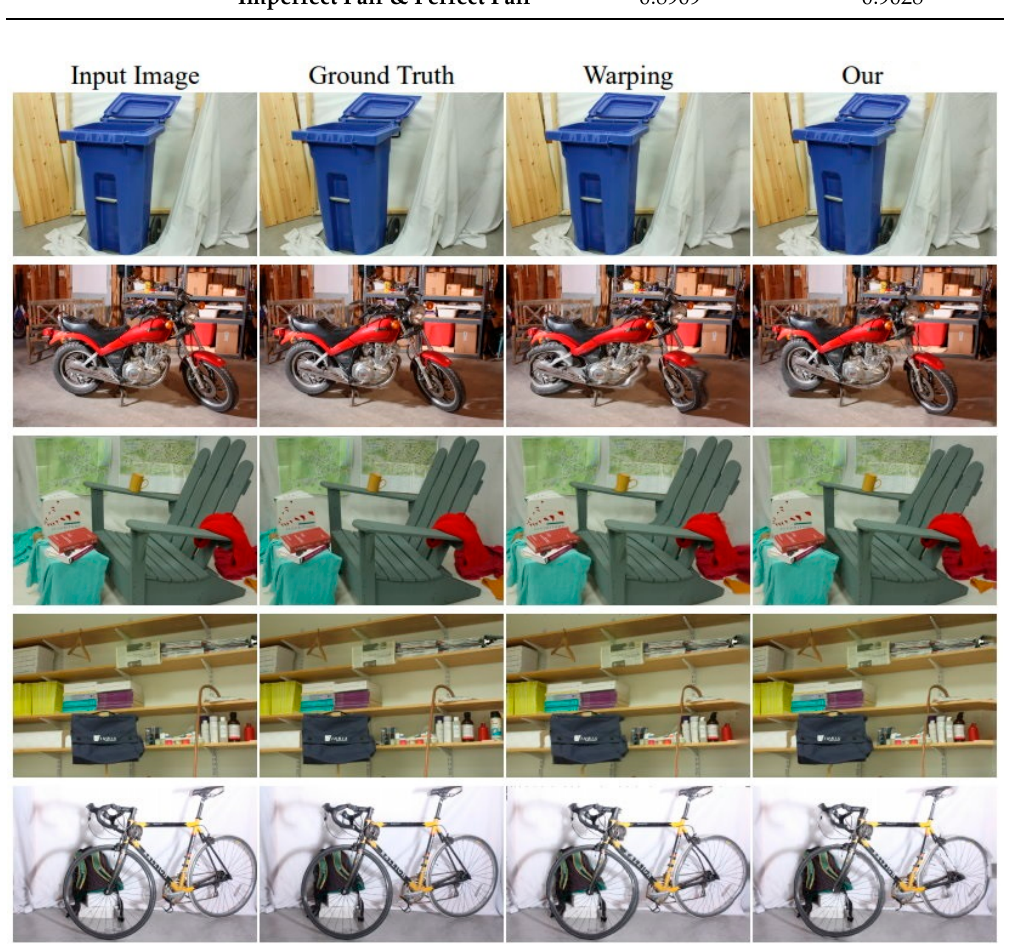
Figure 7. Imperfect-pair images using warping and our model. From top to bottom, these are recycle, motorcycle, adirondack, shelves and